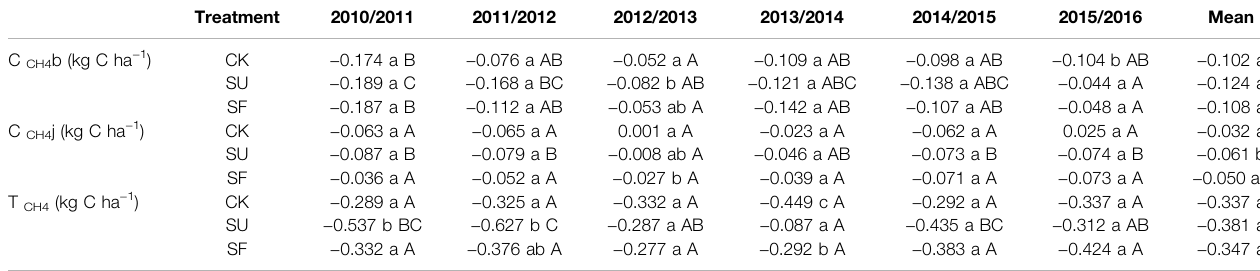
TABLE 2 | Cumulative CH 4 emission and as affected by different treatments.